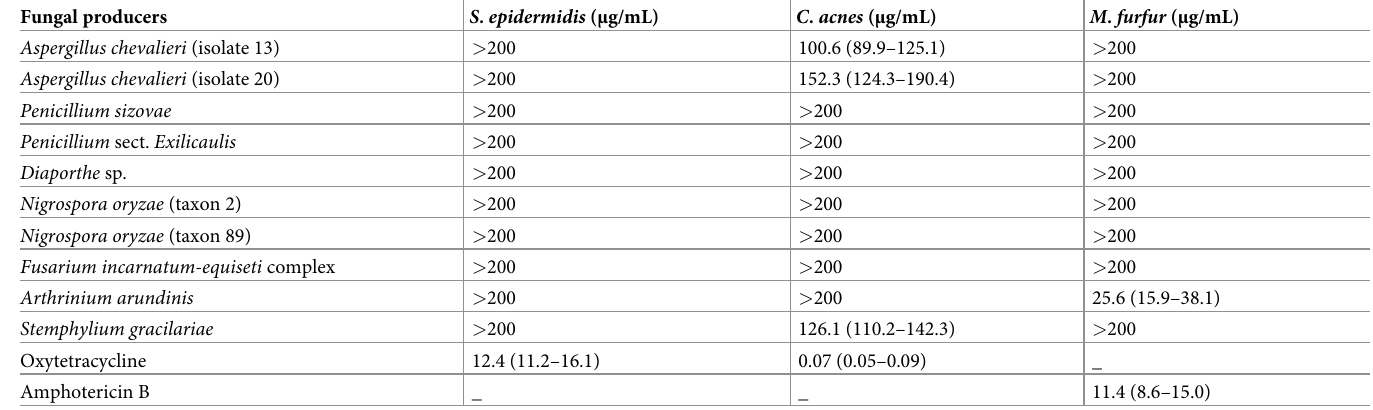
Table 4. Concentration of the fungal crude extracts that causes 50% inhibition of microbial growth (IC 50 ). Fungal producers